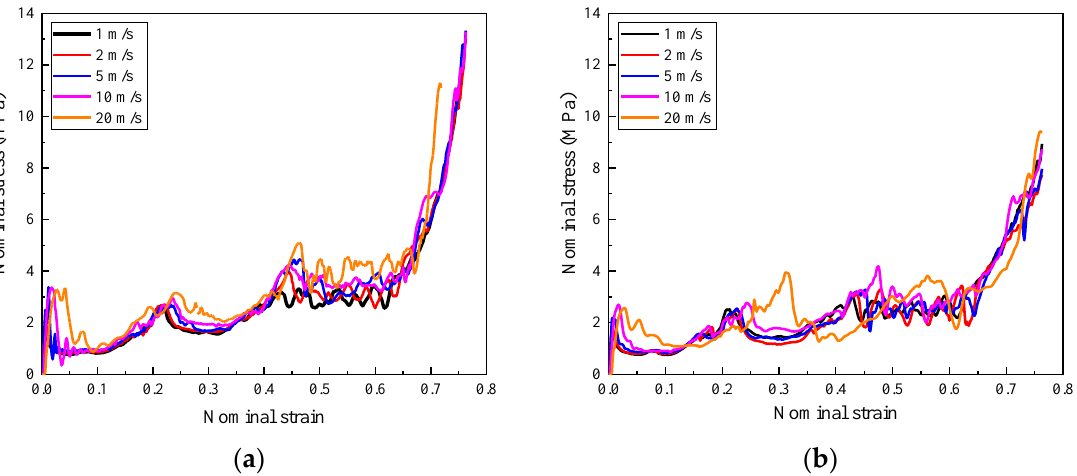
Figure 26. The stress – strain relationships of the composite ( t = 0.4:0.4:0.4) with different foam concrete density gradient directions: ( a ) positive gradient ( ρ = 408:575:848); ( b ) negative gradient ( ρ = 848:575:408).